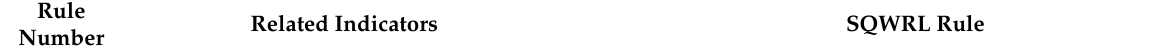
Table 4. SQWRL rules to query related indicators in the case study.